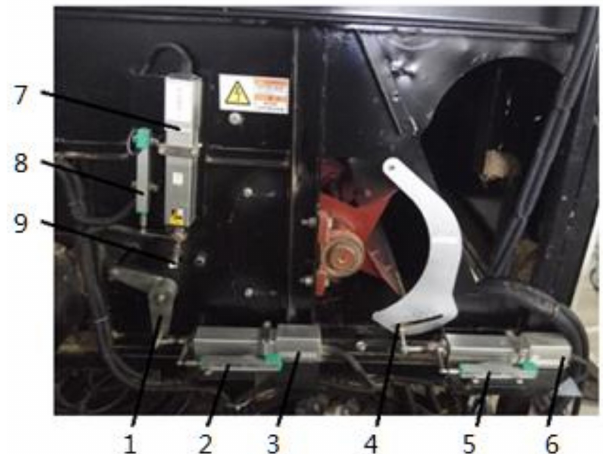
Figure 2. Working principle of the guide plate-angle adjusting system. 1. Direction converter, 2. Displacement sensor 1, 3. Push rod 1, 4. Airflow inlet adjust plate, 5. Displacement sensor 2, 6. Push rod 2, 7. Push rod 3, 8. Displacement sensor 3, 9. Joint bearing.